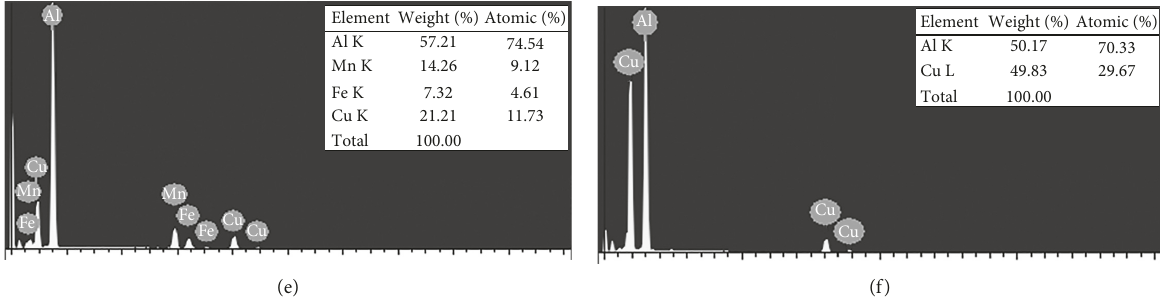
Figure 5: SEM images of Al-Cu-Mn alloys as-cast: (a) A l alloy; (b) A 3 alloy; (c, d) EDS results of the T Mn and θ phases in the A 1 alloy, respectively; (e, f) EDS results of the T Mn and θ phases in the A 3 alloy,